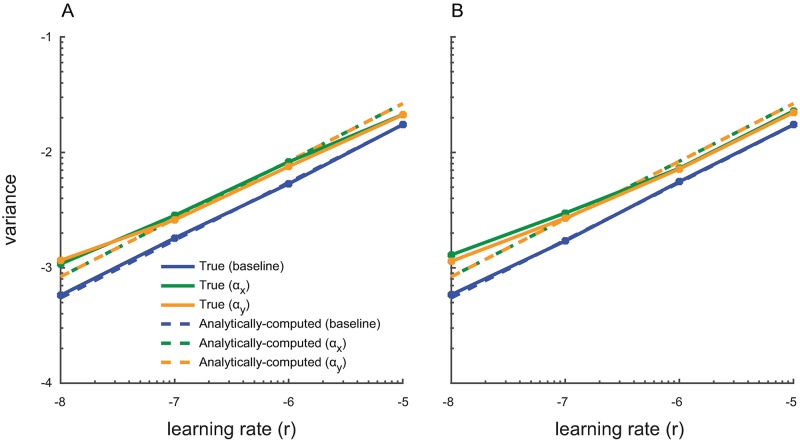
The calibration algorithm accurately computes the steady-state error covariance for discrete spiking activity.(A) The analytically-computed and the true steady-state error covariance as a function of the learning rate r. True values are found from closed-loop BMI simulations with a periodic center-out-and-back trajectory. The calibration algorithm analytically computes the covariance based on (19). The calibration algorithm closely approximates the steady-state error covariance as demonstrated by the closeness of the analytically-computed and true curves across a wide range of r. (B) Figure convention is the same as (A) except that all true values are computed in closed-loop BMI simulations with a non-periodic trajectory generated by selecting one of the eight targets randomly and uniformly in each trial. The calibration algorithm can again closely approximate the steady-state error covariance, demonstrating the generalizability of the approach to training datasets with varying state-evolution trajectories.